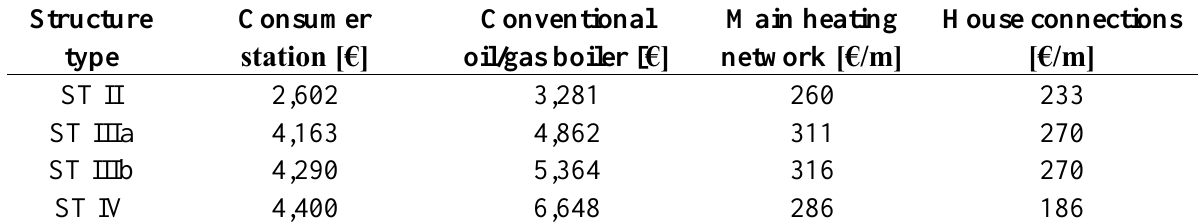
Table 4. Costs per structural type for consumer stations and conventional oil/gas boilers, main heating network, and house connections. Source: [29].